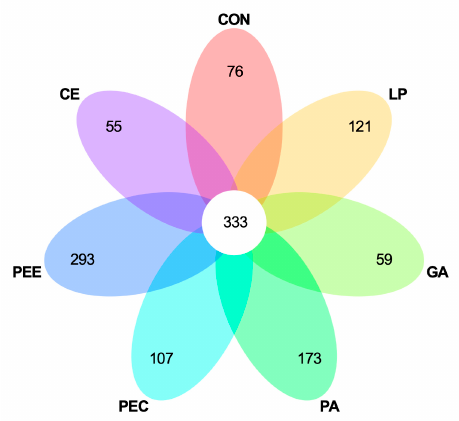
Figure 1. The rarefaction curves of the 16S rRNA gene reads derived from the Sobs index at the operational taxonomic unit (OTU) level after normalization ( A ), principal component analysis (PCA) plot ( B ), and principal coordinate analysis (PCoA) plot ( C ), showing variation in bacterial community structure among the seven alfalfa silage treatments with no additive (CON), Lactobacillus plantarum (LP), gallic acid (GA), phenyllactic acid (PA), pectin (PEC), pectinase (PEE), and cellulase (CE). Each point represents an individual sample.